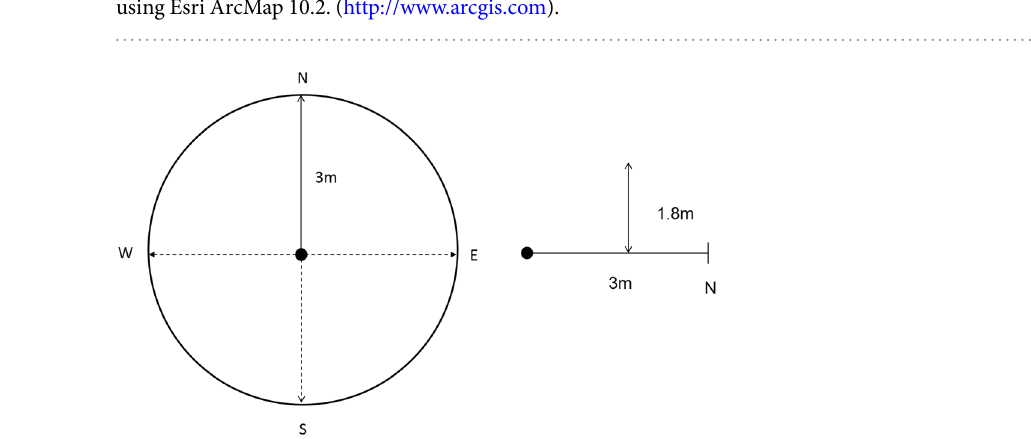
Figure 2. Field site location and experimental design. ( a ) Location of the ten study sites on the Atherton Tablelands, Australia. Study sites are indicated as triangles for intact forests and circles for fragmented forest. Malanda as the nearest town is indicated with an asterix. ( b ) Illustrates the design of vegetation sampling at each study site wherein five 20 × 20 m plots were stratified and randomly placed with respect to the position along the forest edge. The map ( a ) was generated using google earth version 7.1.8.3036 and the inset map was created using Esri ArcMap 10.2. (http://www.arcgis.com).